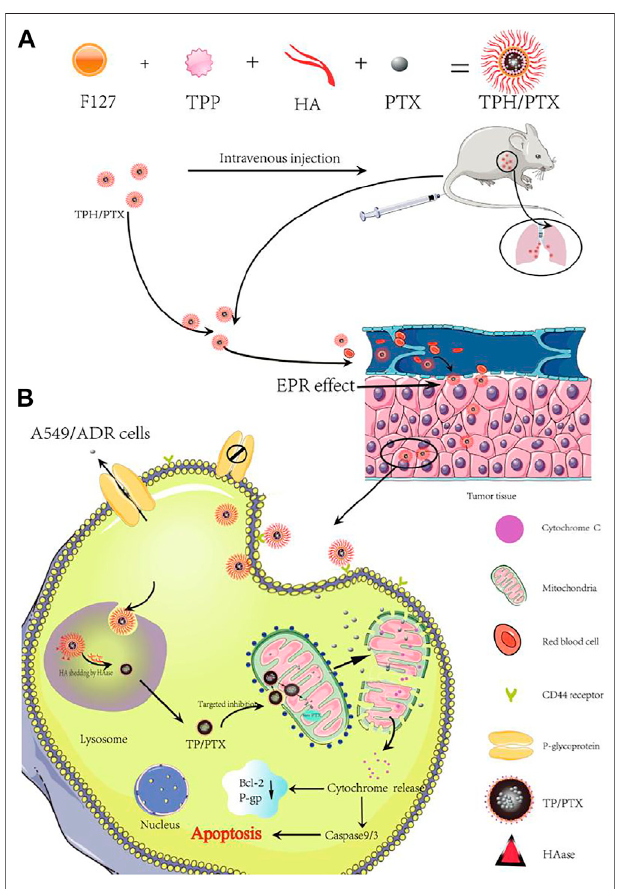
FIGURE 2 | Schematic representation of the assembly of TPH/PTX nanomicelles and the transporting pathway in vivo of TPH/PTX nanomicelles. Reproduced with permission from Wang et al. (2020). Copyright (2020)